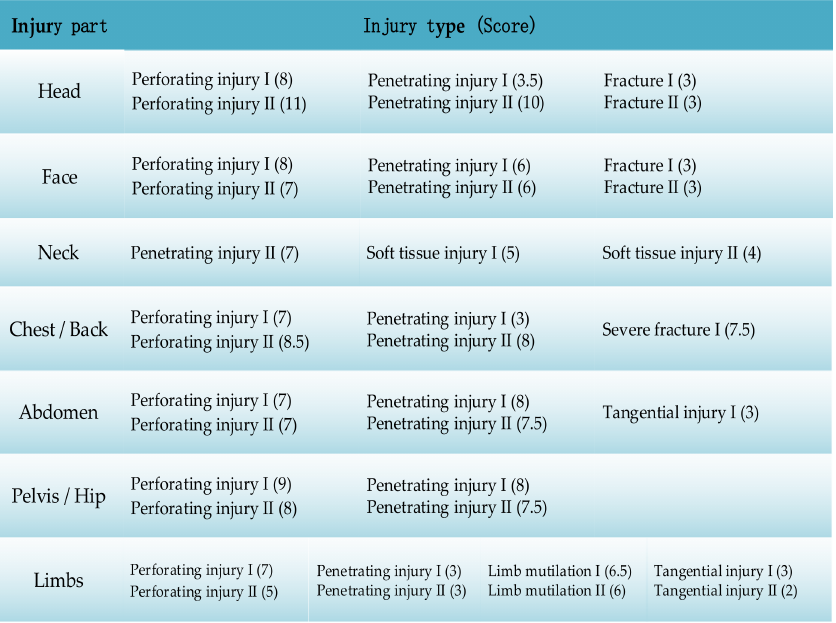
Figure 2. Standard severity score for different injury types. In this Figure, I indicate that the injury is a blast injury, II indicates that the injury is a gunshot wound.